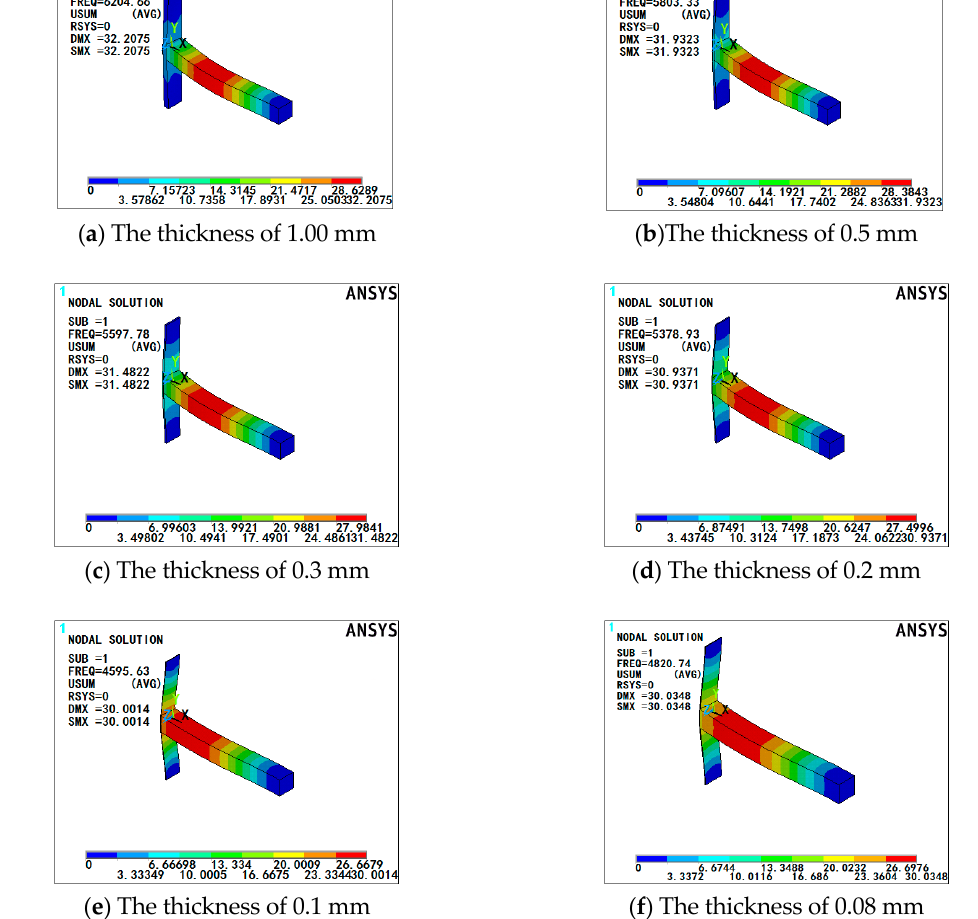
Figure 5. The specific simulation results of the T-shape structure composed of 304 stainless steel of different thicknesses and GMM. ( a ) The thickness of 304 stainless steel is 1.00mm. ( b ) The thickness of 304 stainless steel is 0.50mm. ( c ) The thickness of 304 stainless steel is 0.30mm. ( d )The thickness of 304 stainless steel is 0.20mm. ( e )The thickness of 304 stainless steel is 0.10mm. ( f )The thickness of 304 stainless steel is 0.08mm.